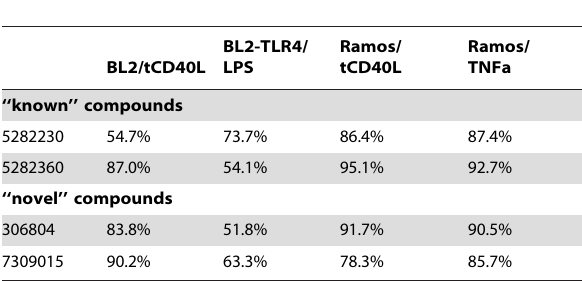
Table 1. Relative IC 50 for two ‘‘known’’ and two ‘‘novel’’ compounds in both BL2-NF k B-Luc and Ramos-NF k B-Luc cell lines.